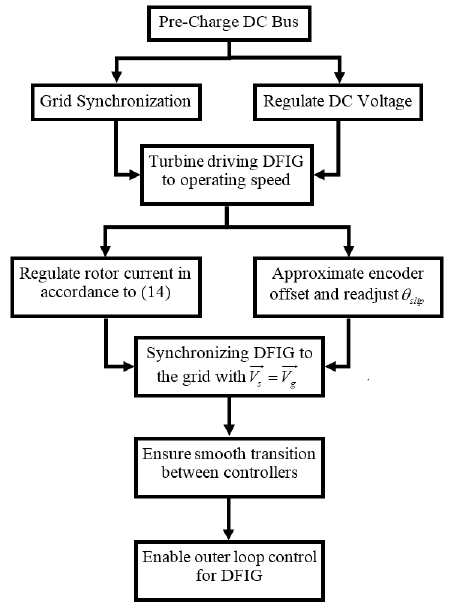
Figure 6. DFIG soft synchronization procedure for unbalanced grid voltages.